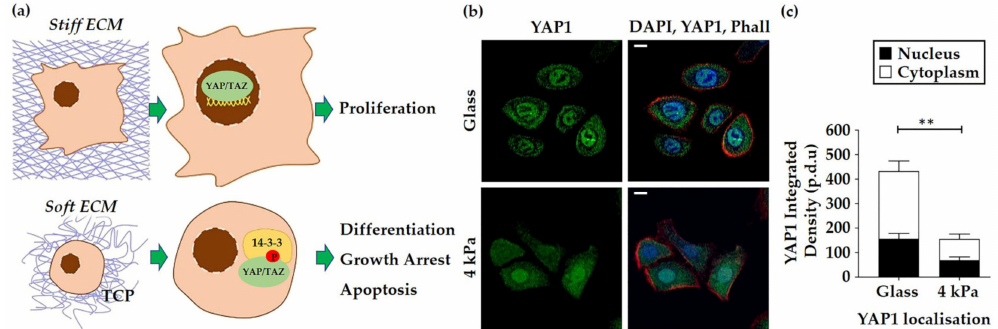
Figure 2. HEK cultured on BMH exhibit altered YAP1 localisation. ( a ) Activation or deactivation of the Hippo signalling pathway on a stiff or soft extracellular matrix (ECM) alters the localisation of YAP/TAZ (nuclear versus cytoplasmic) and determines keratinocyte proliferation or differentiation. ( b ) Representative images of YAP1 localisation in HEK cultured on glass and 4 kPa coverslips. DAPI was used to stain the nucleus and Alexa Fluor-568 conjugated phalloidin to detect F-actin. Scale bars: 10 µ m. ( c ) Quantification of integrated density of YAP1 in the nuclear and cytoplasmic compartments of HEK on glass and 4 kPa BMH coverslips. Data represent mean ± SEM, n = 3, statistical significance was assessed using an unpaired t -test, ** p ≤ 0.001. Both the total YAP1 integrated density as well as the individual YAP1 integrated intensities measured within the nuclear and cytoplasmic compartments were significantly reduced in cells grown on 4 kPa